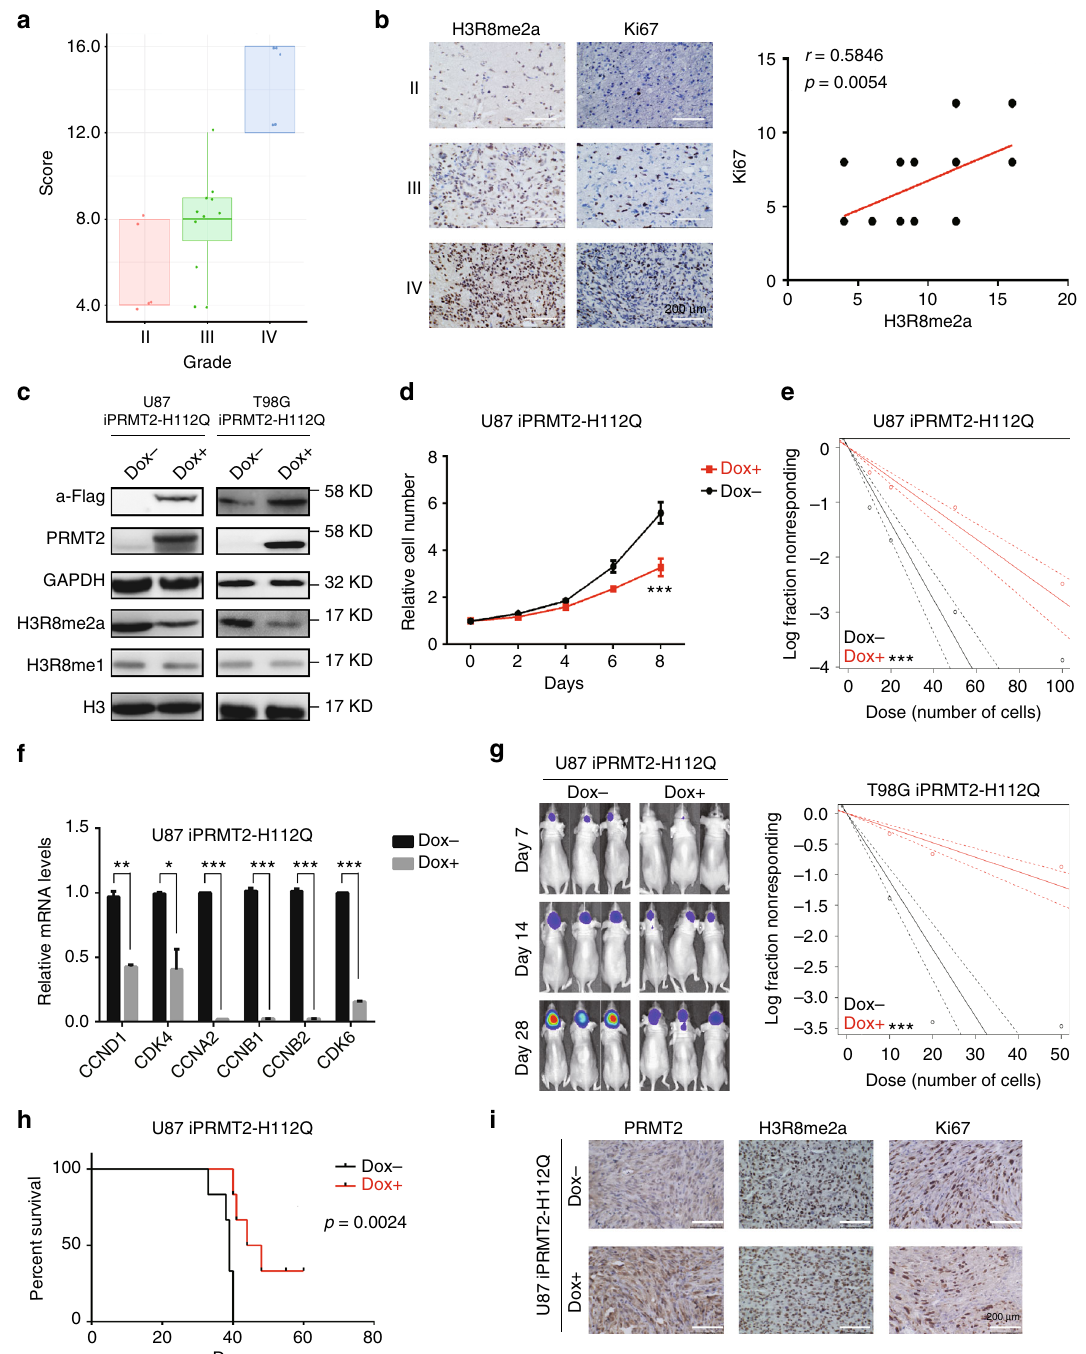
RT-qPCR and immunoblotting . Total RNA isolated using Trizol reagent (Ambion) was subjected to reverse transcription with Superscript Reverse Tran- rPO was used as a reference gene for all qRT-PCR experiments and analyses. The ΔΔ Ct method was used for quanti fi cation analysis. To obtain whole-cell protein extracts or histones, cells were lysed or extracted as previously described 46 . Membranes were blotted with the corresponding primary antibodies: